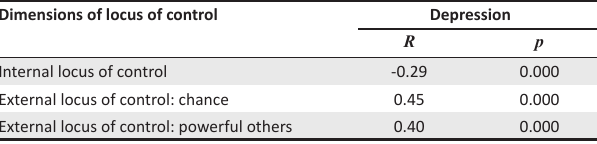
TABLE 2: Associations between locus of control and depression. Dimensions of locus of